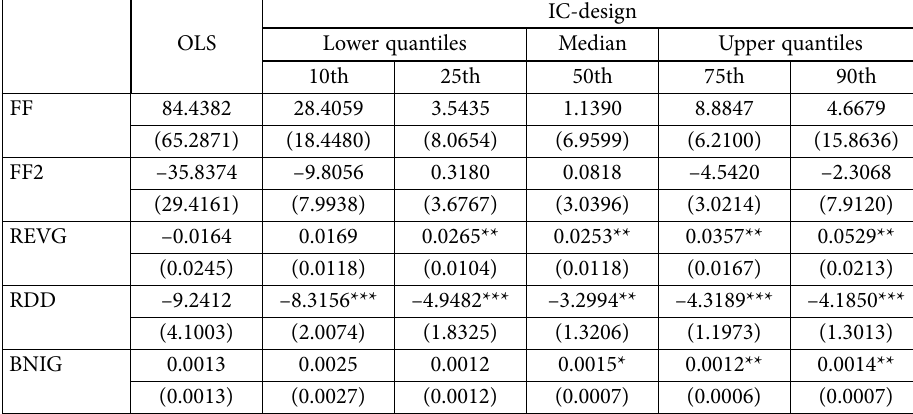
Table 17. Summary of OLS and QR results for ICdesign and IC-manufacturing in